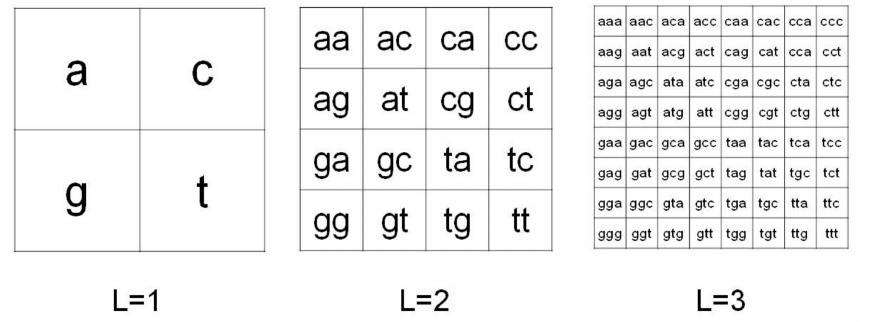
Figure 3. Chaos Game Representation method. CGR organization in matrices 2 L x2 L for L = 1,2,3 in the case of four-symbol alphabet